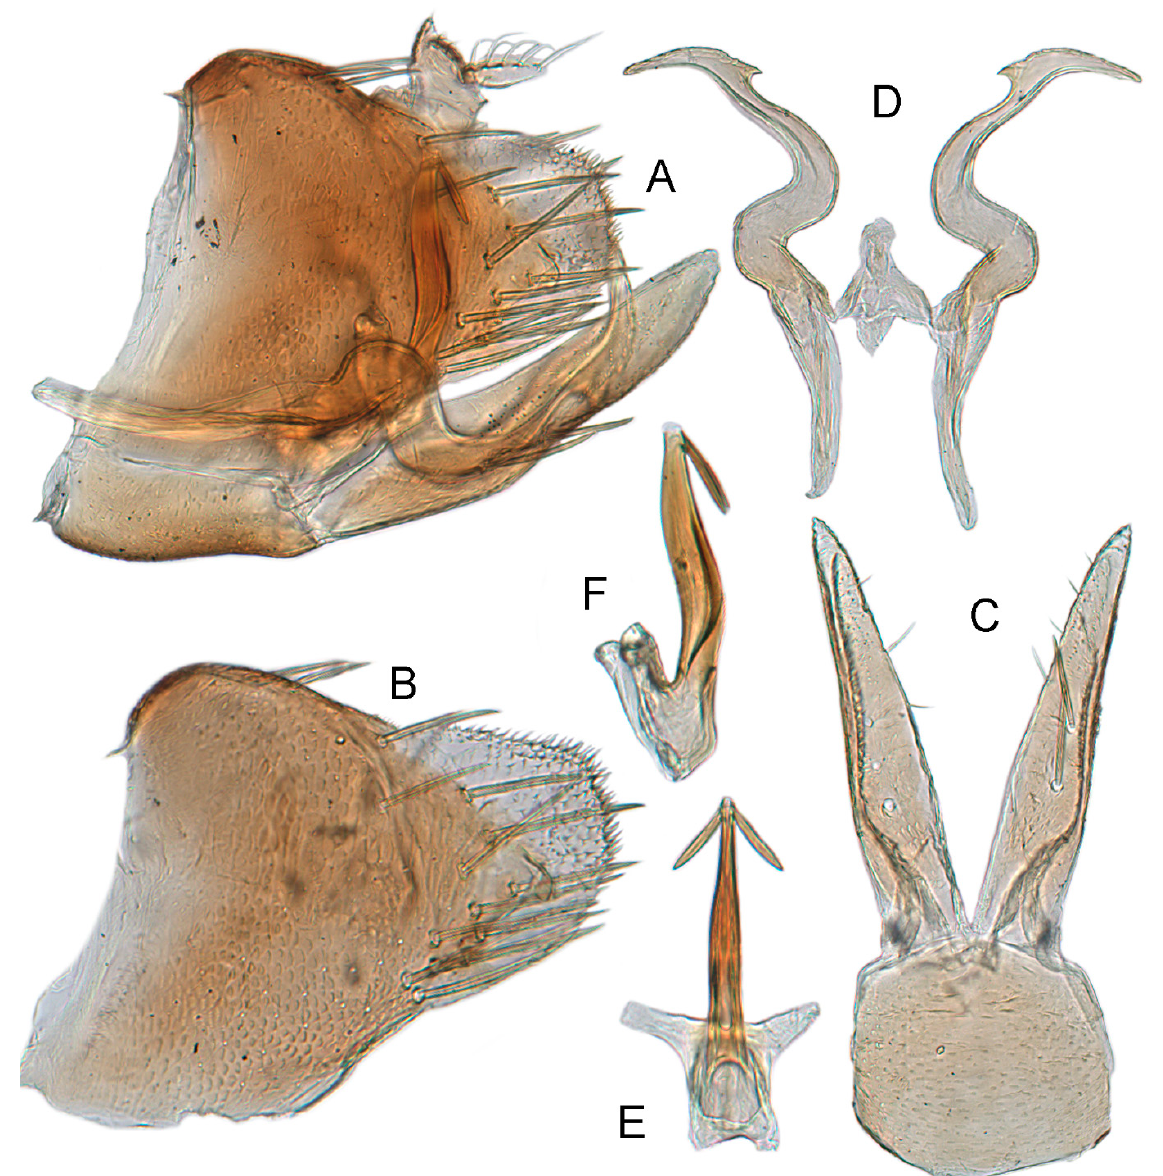
Figure 9. Xestocephalus binarius sp. nov. ( A ) Male genital capsule, lateral view; ( B ) pygofer lobe, lateral view; ( C ) subgenital plates and valve, ventral view; ( D ) style and connective, ventral view; ( E ) aedeagus, posterior view; ( F ) aedeagus, lateral view.